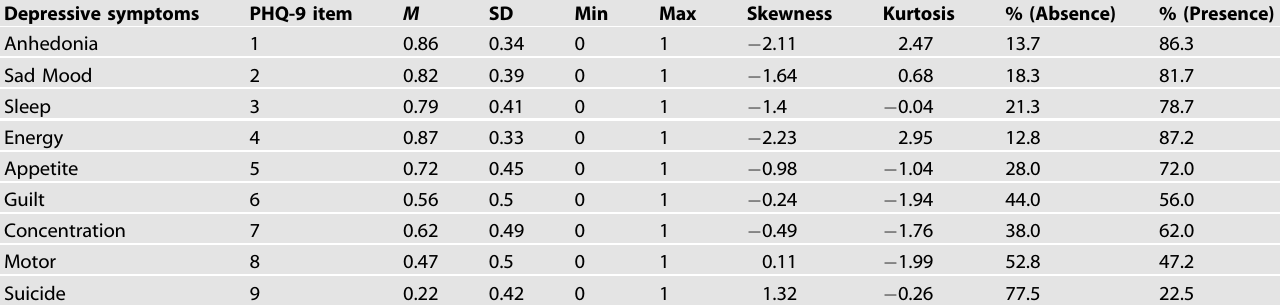
Table 2. Mean, standard deviation, minimum, maximum, skewness, and kurtosis, and frequency of depressive symptoms as measured by the PHQ-9 ( N = 11 072).